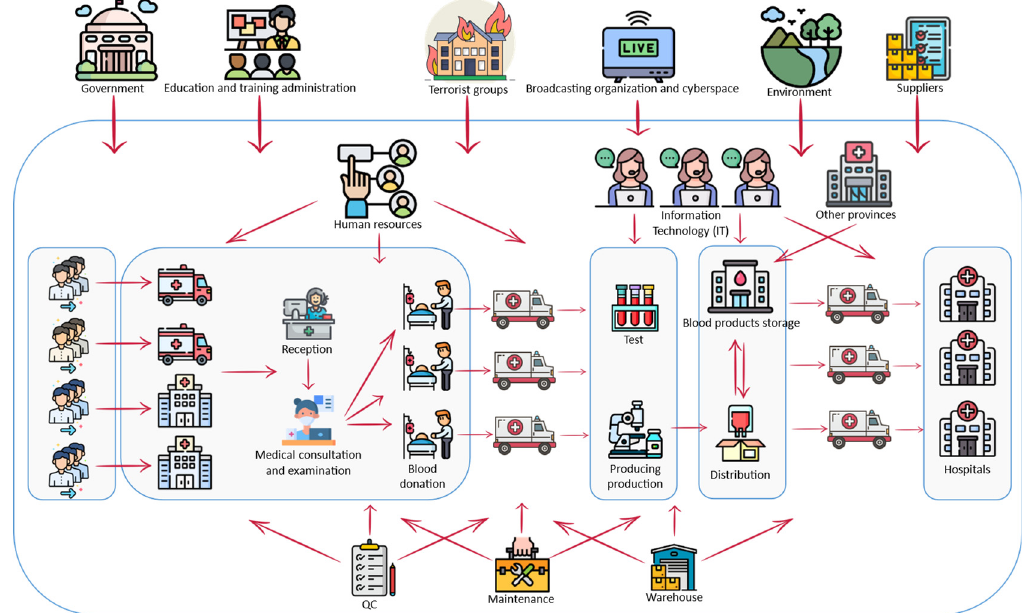
Figure 3. The rich picture of the BSC.